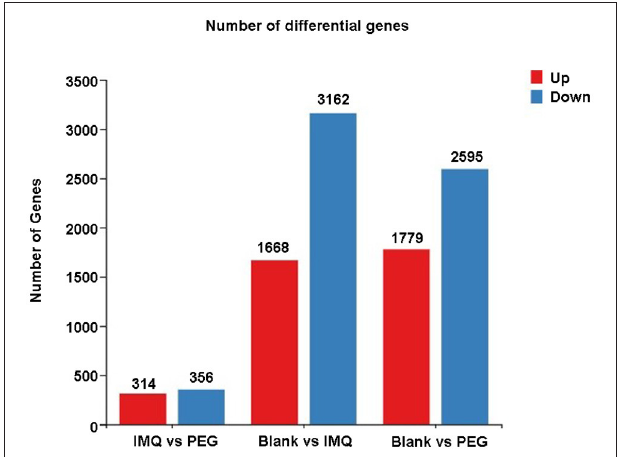
FIGURE 3 | A statistical graph of differential gene expression among the three groups. Red represents up-regulated genes and blue represents down-regulated